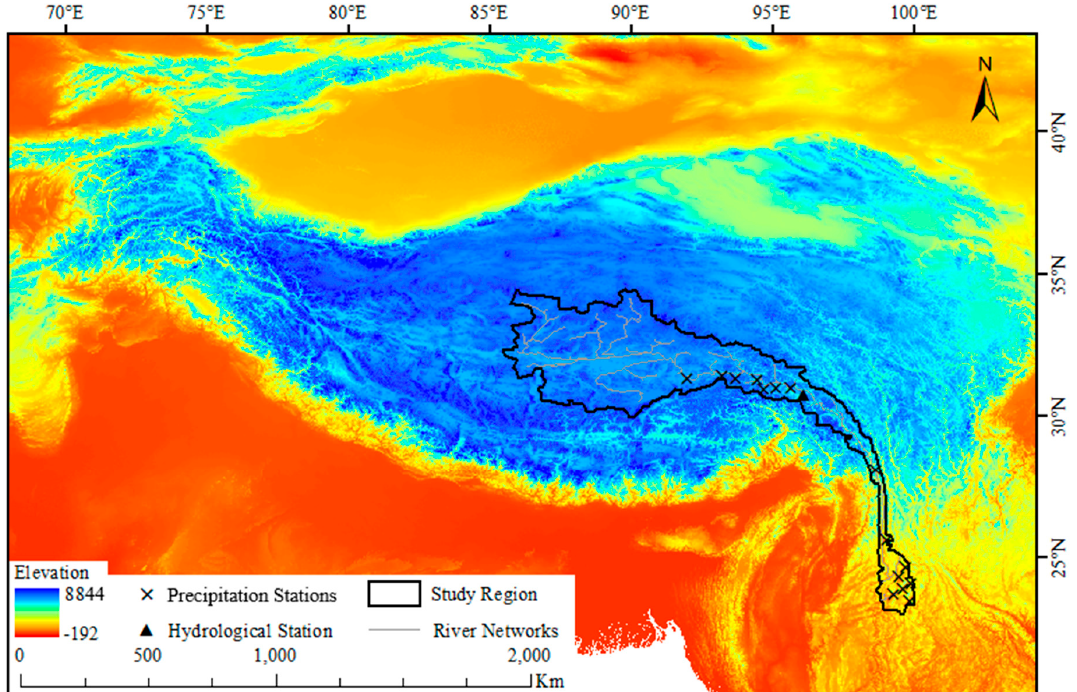
Figure 1. Location and elevation of the Nujiang River (upper and middle Salween River) basin. Where the river networks, hydrological station, and precipitation stations used in this study are also plotted. The Jiayuqiao hydrological station is given in black triangle.